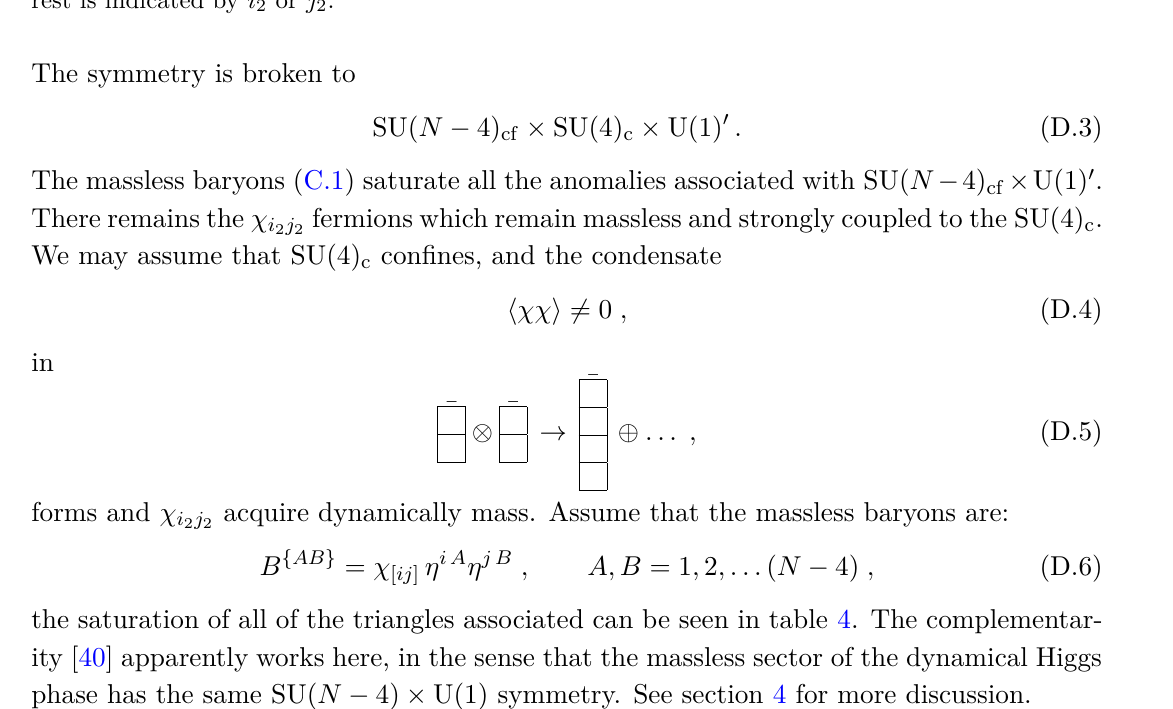
Table 4 . Color-flavor locking in the χη model. The color index i 1 or j 1 runs up to N − 4 and the rest is indicated by i 2 or j 2